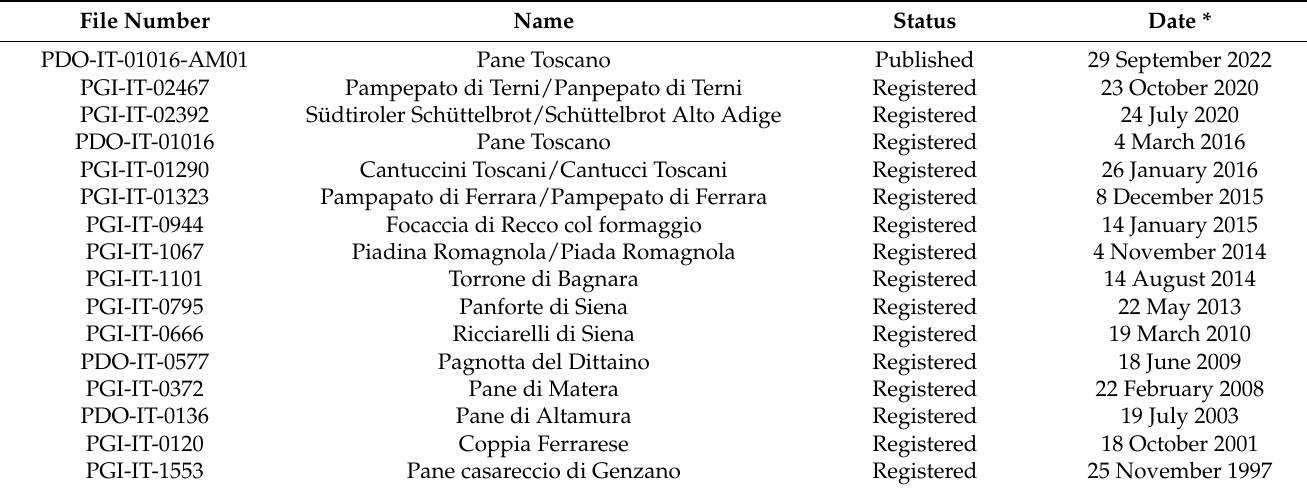
Table 1. Class 2.3. Bread, pastry, cakes, confectionery, biscuits and other baker’s wares. Product type Food, PDO and PGI in Italy (Data of January